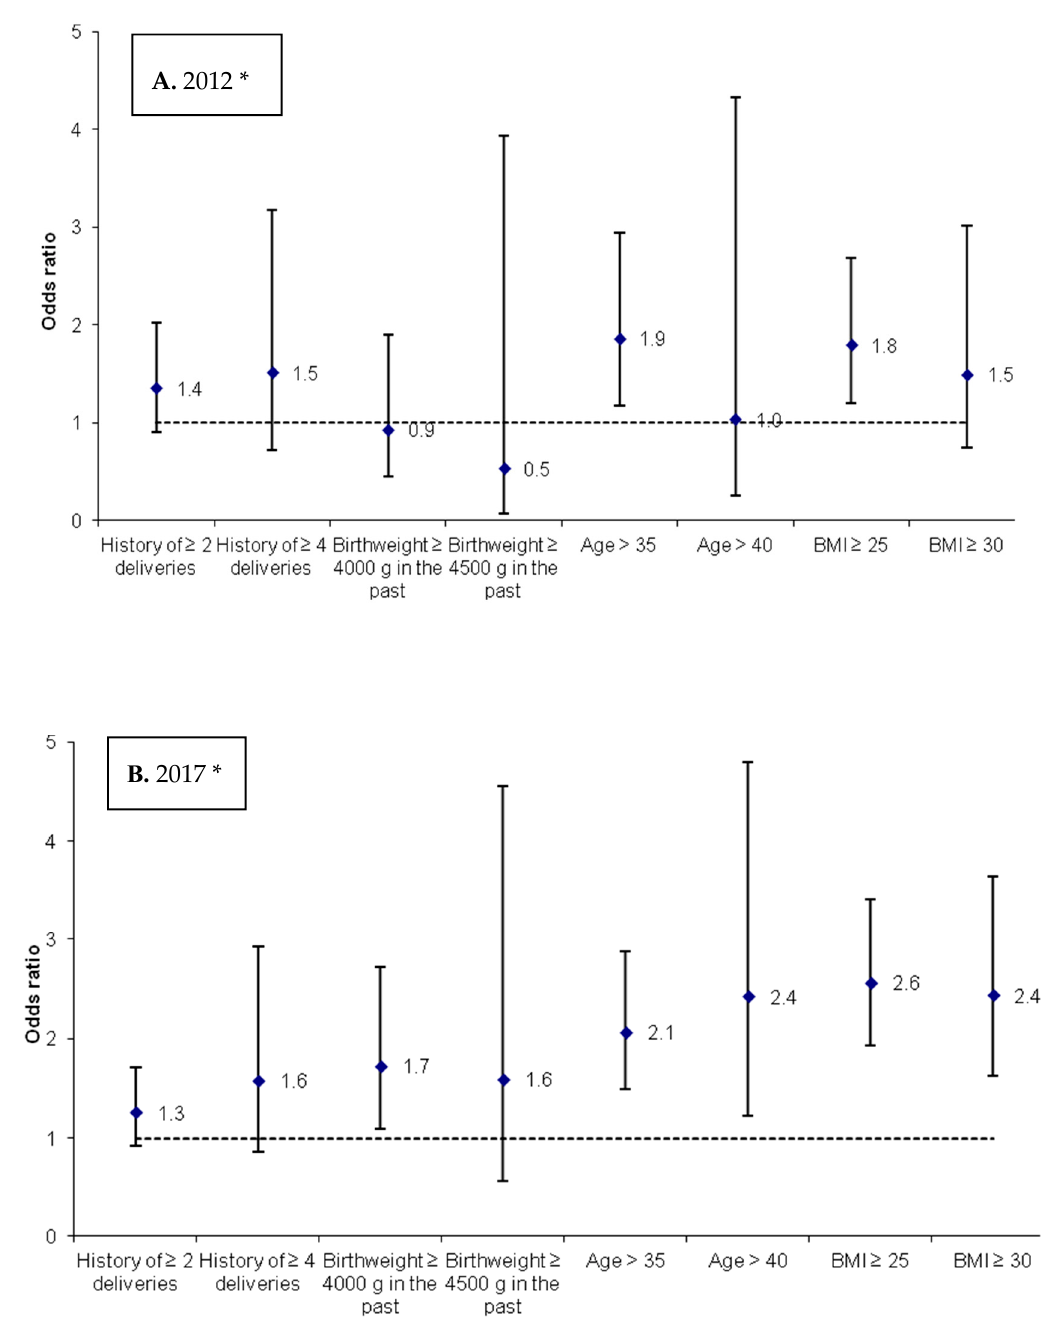
Figure 1. Risk factors of gestational diabetes mellitus in years 2012 ( A ) and 2017 ( B ). (* a group of women belonging to the complementary category of an individual variable was a reference category for each of the variables).